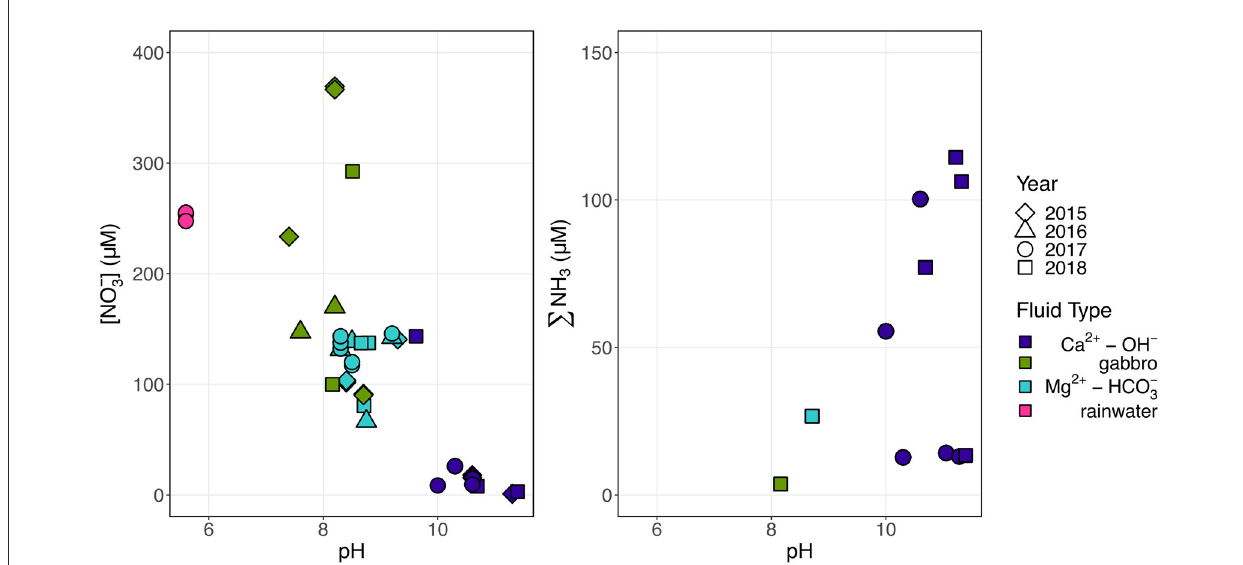
FIGURE2 Trend of decreasing NO − 3 concentrations and increasing year of